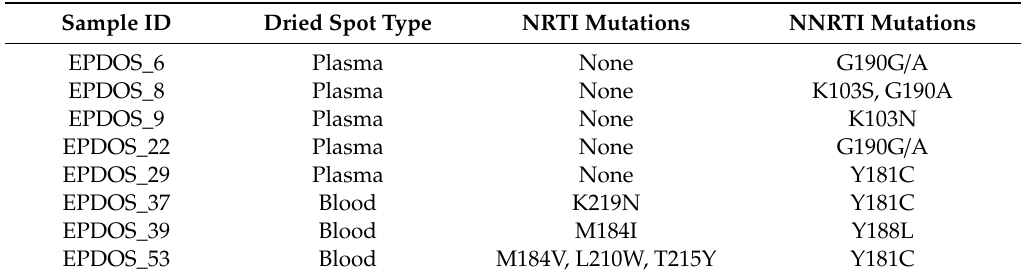
Table 3. Mutational profiles of participants harboring HIV-1 antiretroviral drug resistance. Sample